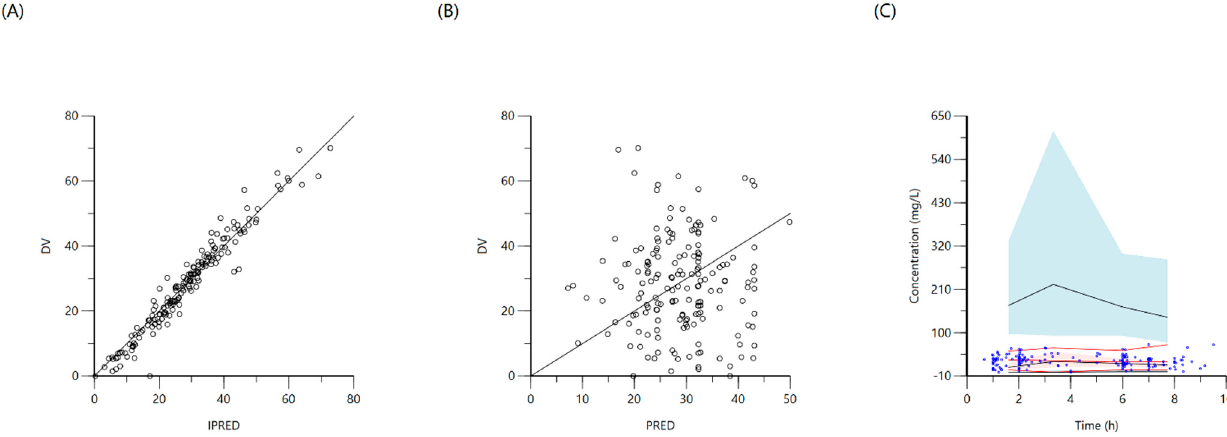
Figure 5. Goodness-of-fit plots for final population models of pyrazinamide. Plot ( A ) represents individual predicted con- centrations (IPRED) versus observed concentrations (DV), whereas plot ( B ) represents population-predicted concentrations (PRED) versus observed concentrations (DV). Plot ( C ), visual predictive check (VPC) for concentrations of pyrazinamide versus time based on 1000 Monte Carlo simulations. Blue circles represent observed pyrazinamide concentrations, solid red lines represent the 5th, 50th and 95th percentiles of the observed concentrations, solid black lines represent the 5th, 50th and 95th percentiles of the simulated concentrations, and the shaded area represent the 90% CI of the 5th, 50th and 95th percentiles of the simulated concentrations.